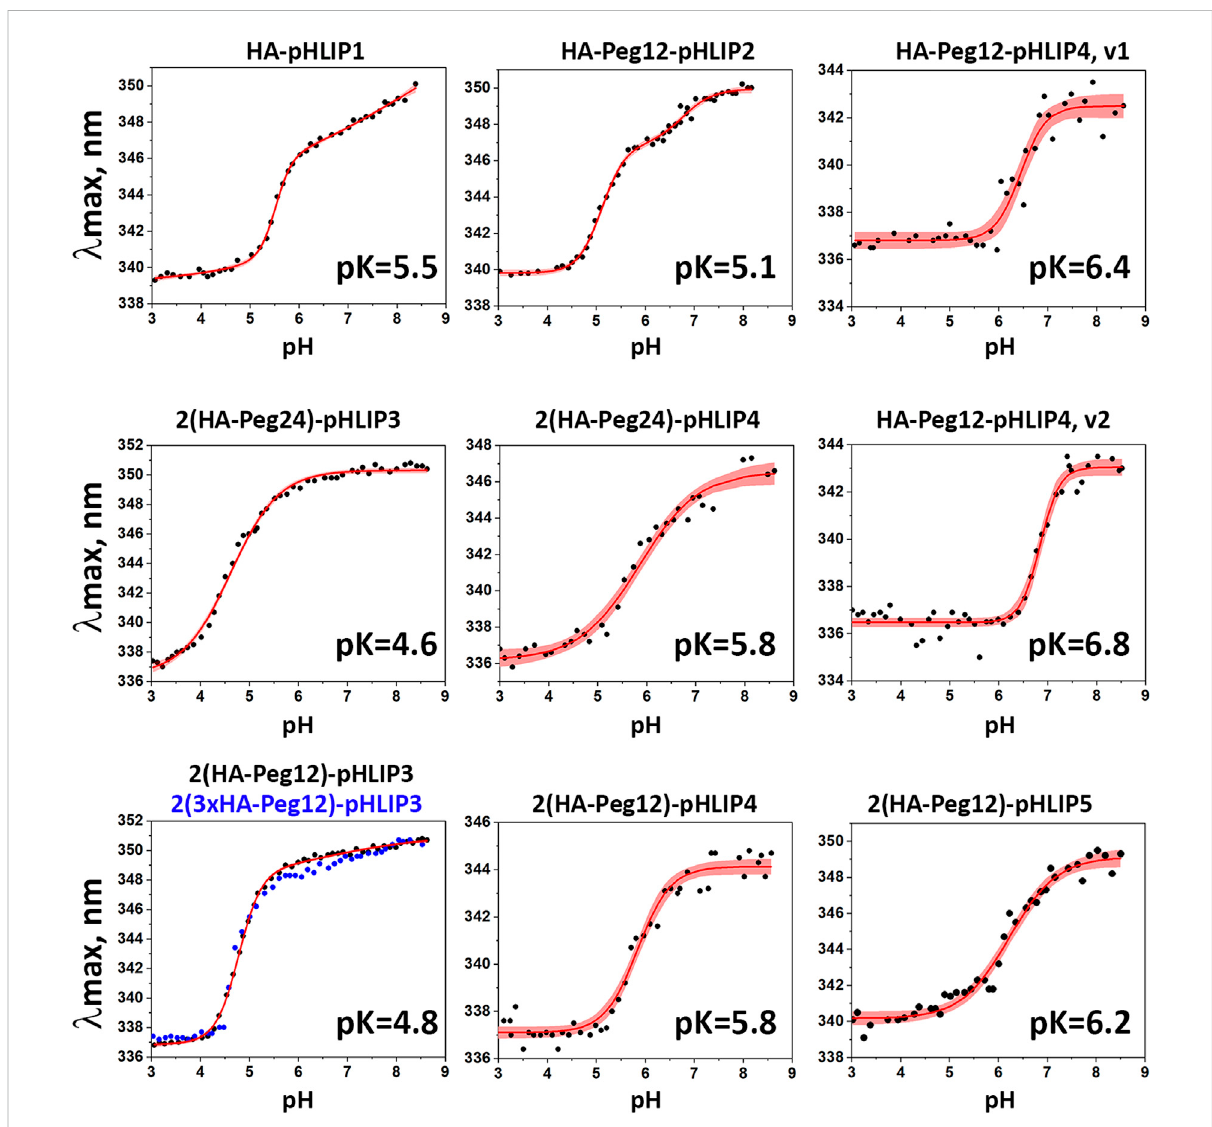
FIGURE 4 pH-dependent interactions of HA-pHLIP constructs with liposome bilayers. pH transitions from state II to state III as monitored by changes of the fl uorescence maximum of HA-pHLIP agents are shown (experimental points and fi tting curves, red, with 95% con fi dence interval,